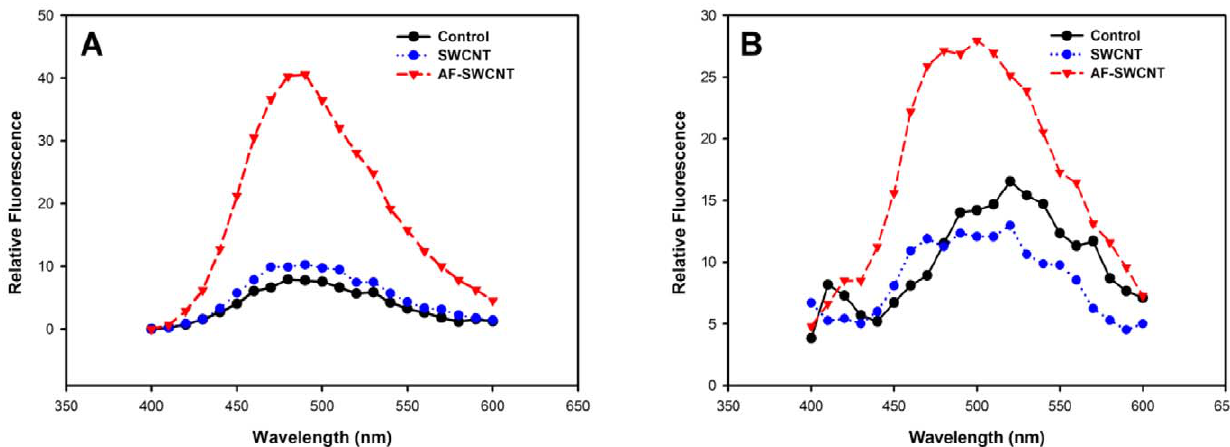
Figure 4. Effect of treatment with control and acid functionalized SWCNTs on hydrophobicity of erythrocyte membrane. Erythrocytes (5 6 10 6 /ml in PBS + 1%FBS at 37 u C) from Swiss (panel A) and C57Bl6 (panel B) mice were incubated with 25 m g/ml of SWCNTs and AF- SWCNTs for 1 h. Cells were washed and incubated in PBS with 4 mM ANS for 20 min in dark at 37 u C, after which fluorescence spectra was determined on a fluorimeter.